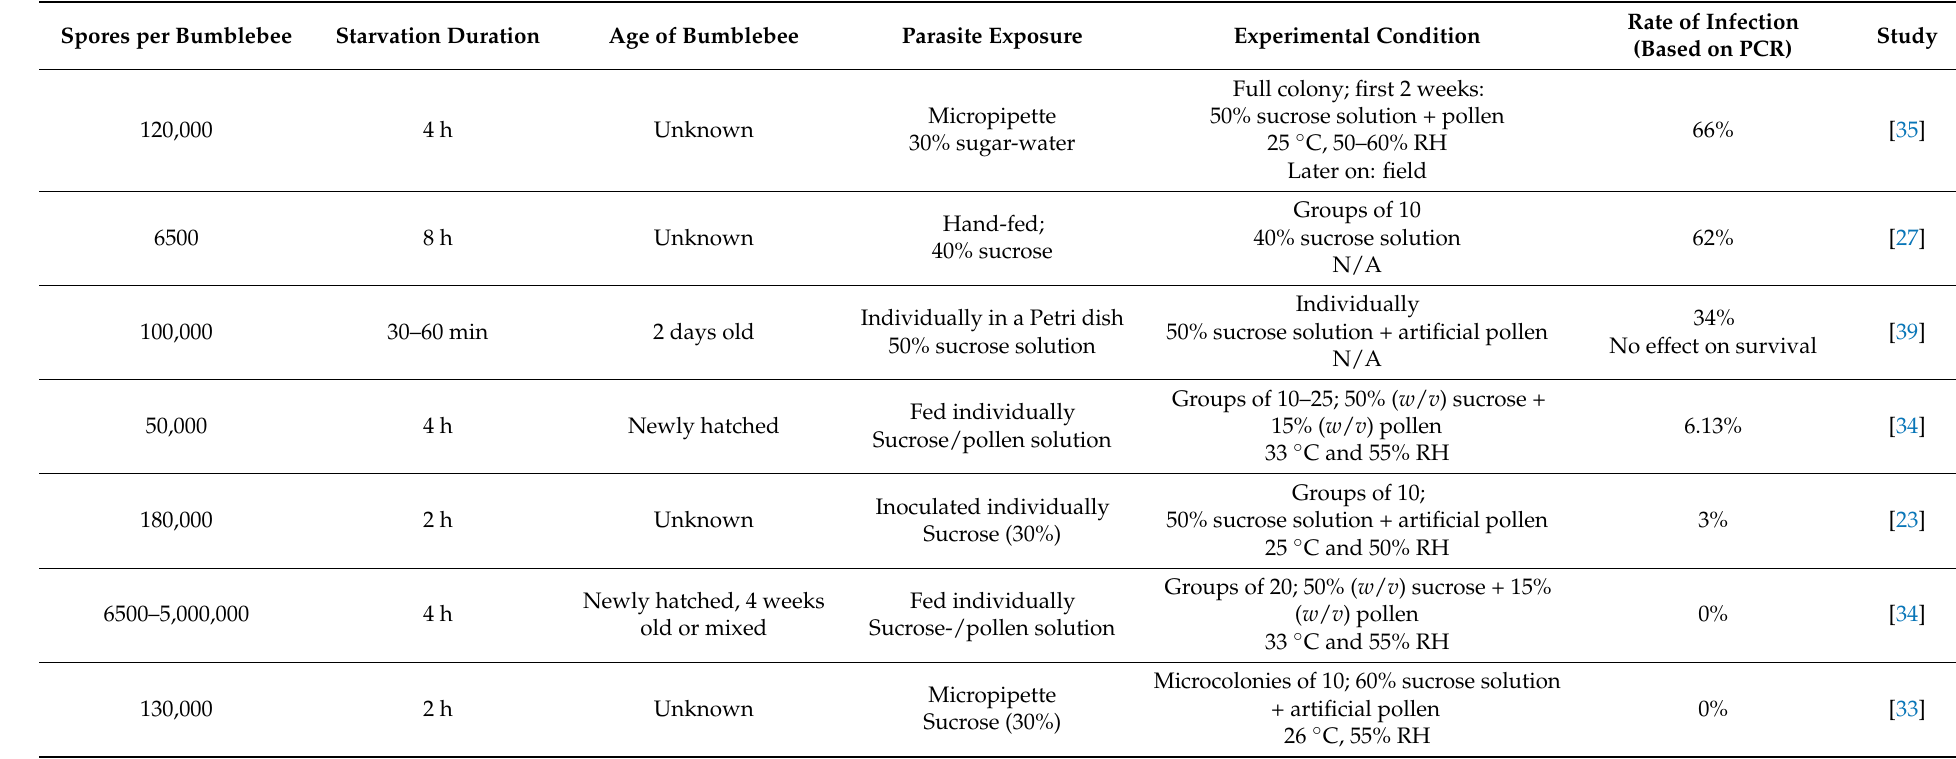
Table 1. Summary of protocols developed to infect bumblebees ( Bombus terrestris ) with Nosema ceranae